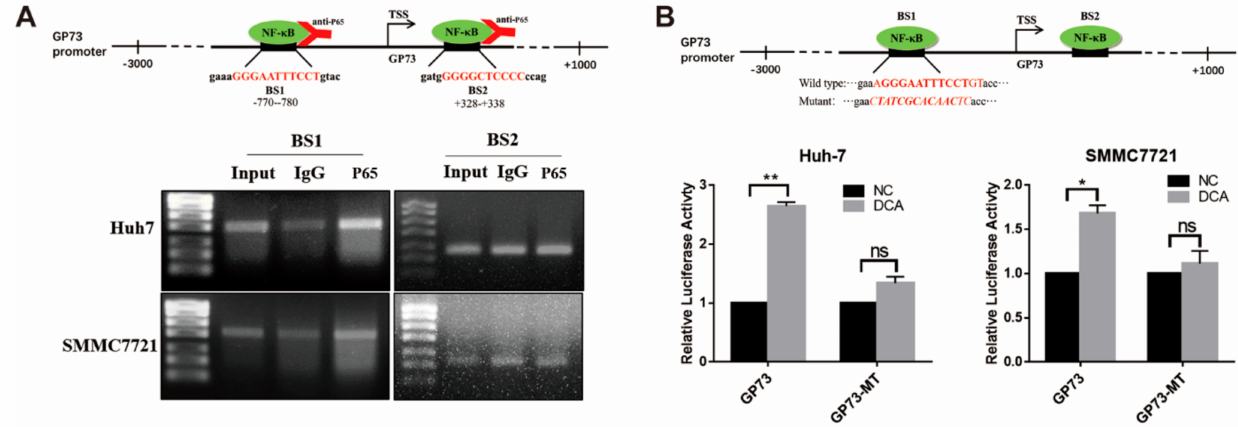
Figure 4. NF- κ B P65 directly binds to the promoter of Golgi protein 73 (GP73). ( A ) Schematic diagram of chromatin immunoprecipitation (ChIP) PCR (upper). The products of ChIP-PCR in the input, immunoglobulin G (IgG), and ChIP groups were analyzed using agarose gel electrophoresis (lower). ( B ) Schematic diagram of NF- κ B P65 binding site 1 mutant (upper). Huh-7 and SMMC7721 cells were transfected with PGL3-GP73 or GP73-MT and treated with or without 100 µ M deoxycholic acid (DCA). Samples were harvested 48 h after treatment, and luciferase activities were measured (lower). Data in B are expressed as the mean ± SEM and represent three independent experiments (* p < 0.05; ** p < 0.001; ns: not significant). Statistical analysis was performed using GraphPad